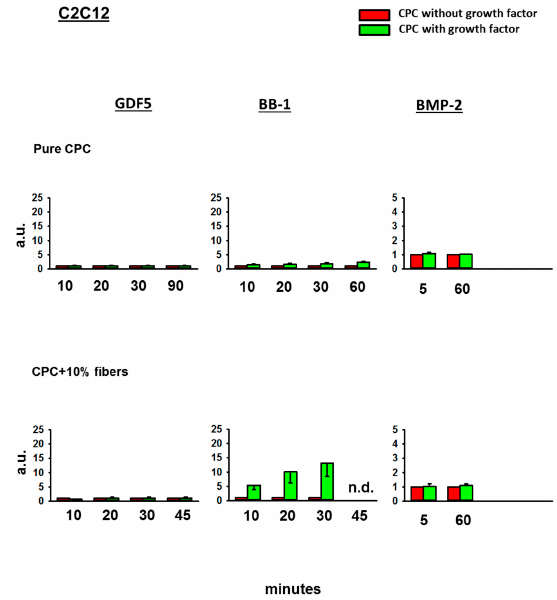
Figure 4. Alkaline phosphatase (ALP) activity in C2C12 cells. C2C12 cells were cultivated for 3 days in diluted extracts of GDF5, BB-1, or BMP-2-containing, ground pure CPC or PLGA